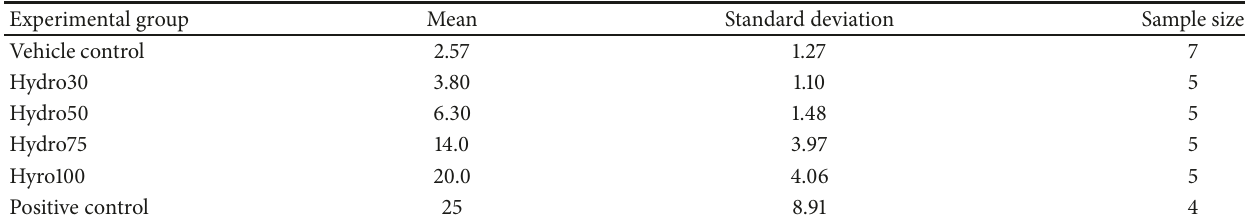
Table 3: Number of micronuclei per animal and 2000 scored cells for the negative control, four doses of hydroquinone and positive control cyclophosphamide.